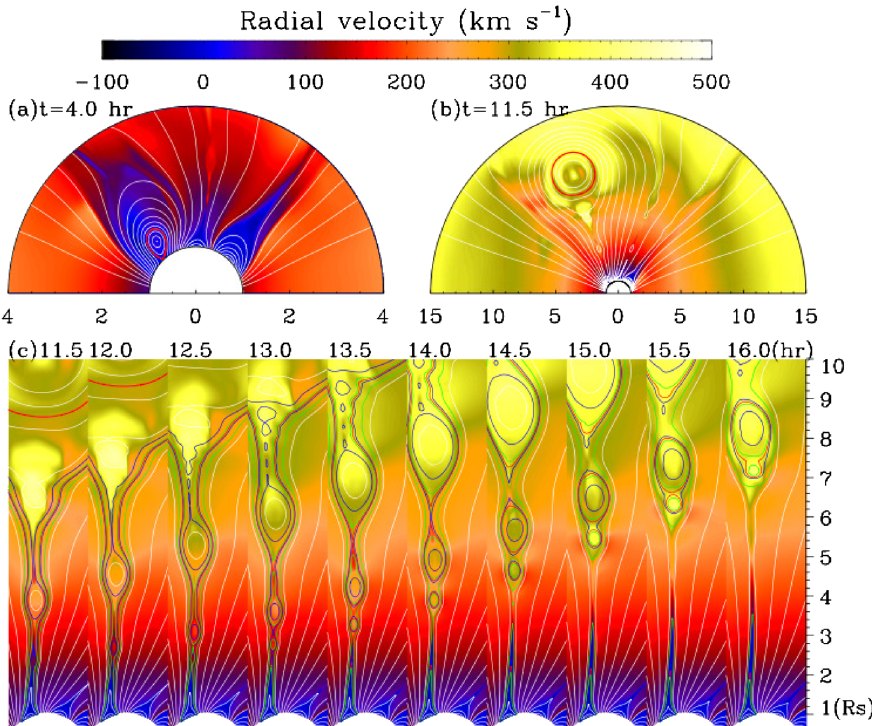
FIG. 3. A 2.5-D axisymmetric MHD simulation based on the catastrophic flux-rope model showing the generation and the merging of multiple blobs in the current sheet behind a CME eruption. (a),(b) Snapshots at times t ¼ 4 : 0 h : and t ¼ 11 : 5 h : , respectively. White lines are magnetic fields. The colors depict the radial velocity, matching the legend across the top of the figure. The CME is modeled by a flux rope, represented by the red circles in (a),(b), that emerges from the bottom center of the leftmost streamer. (c) is a time sequence of 10 frames, 30 minutes apart, from t ¼ 11 : 5 to t ¼ 16 h : It represents a plot enlargement along the current sheet behind the CME. The width of the slide (i.e., the horizontal size) in each frame in (c) is 2 R (cid:2) . Two animations of blob generation and coalescence corresponding to (a),(b) can be found online [32]. Note that, as can be seen from the online animations, blob formation and coalescence can also occur along the streamer plasma sheet that is strongly disturbed by the t ¼ 12 h : , a second blob is formed. At t ¼ 13 : 0 h : , the parameter (cid:1) 0 ¼ 4 : 023 (cid:4) 10 13 Mx is the unit of magnetic second blob moves up to h ¼ 3 : 8 R (cid:2) , and a third blob is flux. The system further evolves. At time t ¼ 4 h : , two hours after the flux rope emerges, the radial-velocity field formed at h ¼ 2 : 8 R (cid:2) . The third blob moves faster than from 1 to 4 R (cid:2) is shown as the contour map in Fig. 3(a) with the second, and, by t ¼ 15 h : , they started to merge. The the value of the velocity given by the color bar at the top of merging continues until t ¼ 16 h : , when the center of the merged blob reaches a height of h ¼ 8 R (cid:2) (with the top Fig. 3. Superposed curves are the magnetic-field lines, edge at 9 R (cid:2) and the lower end at 6 : 8 R (cid:2) ). The simulation where the thick red curve depicts the outer border of the flux rope. The flux rope erupts at t ¼ 4 hr. After another 7.5 hours, the velocity field and the magnetic field evolve to